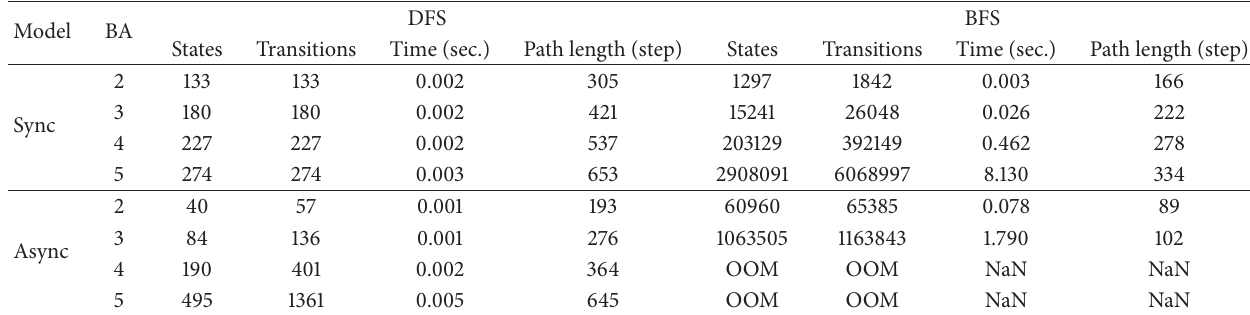
Table 5: Experimental results of property p